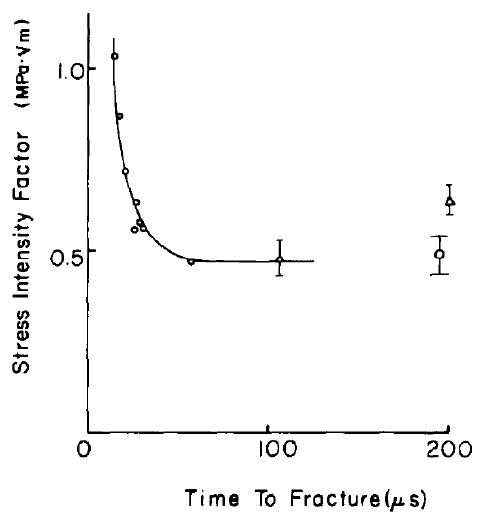
Figure 21. The stress intensity factor at initiation as a function of the time at initiation [83].